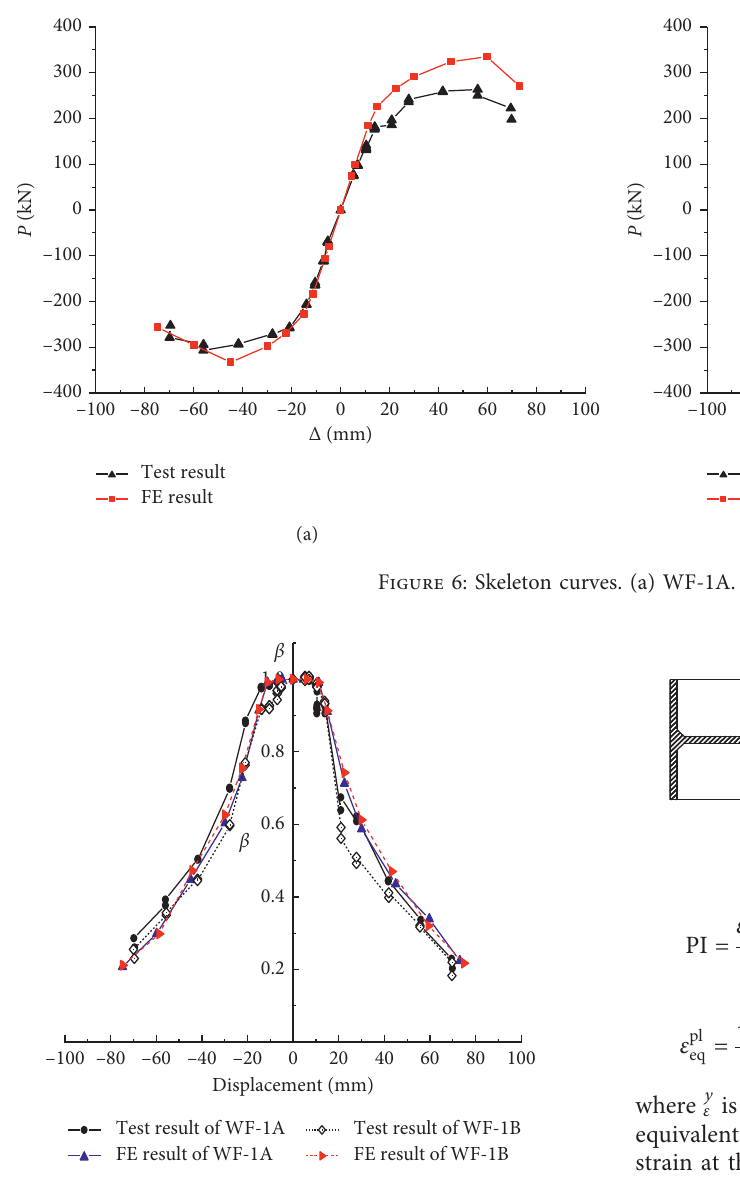
Figure 7: Stiffness degradation curve of WF-1.